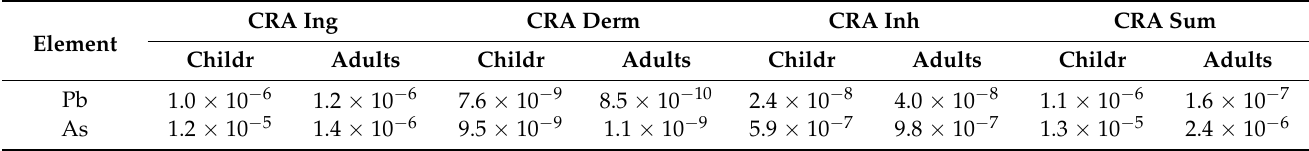
Table 8. Carcinogenic risk (CRA) values of Pb and As through all exposure pathways in Surgut city. CRA Ing CRA Derm CRA Inh CRA Sum Element Childr Adults Childr Adults Childr Adults Childr Adults Pb 1.0 × 10 − 6 1.2 × 10 − 6 7.6 × 10 − 9 As 1.2 × 10 −